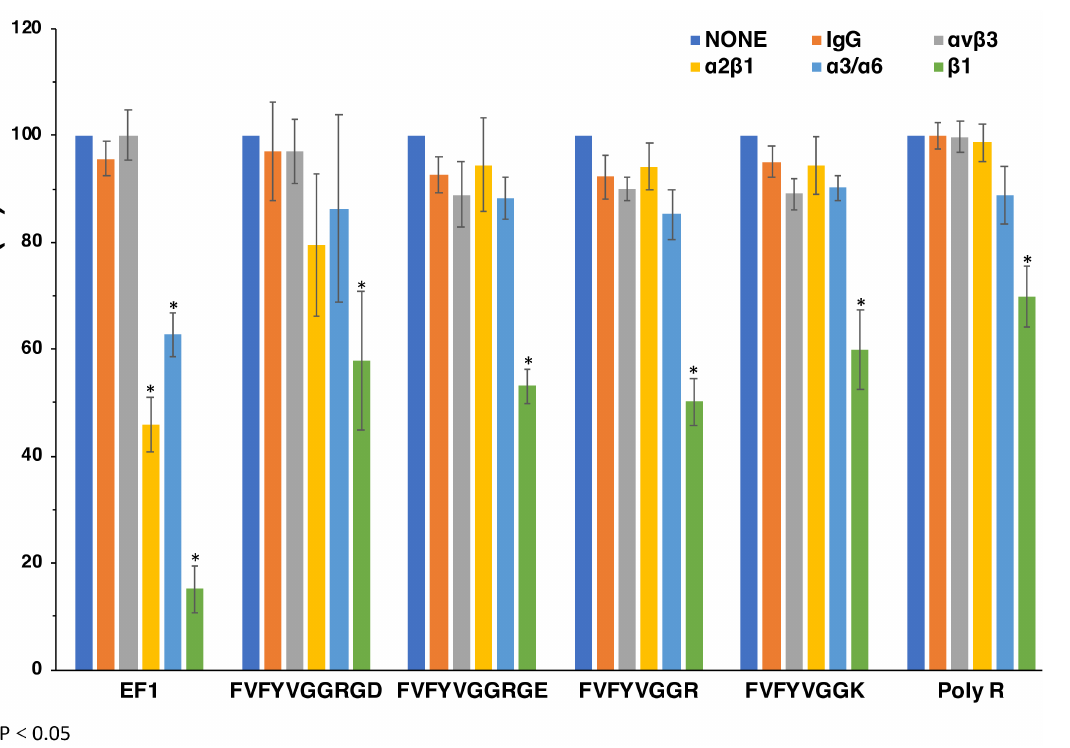
Figure 7. Effect of anti-integrin antibodies on cell attachment to peptides. HDFs were preincubated with 10 µ g/mL of the integrin antibodies at room temperature for 15 min and added to the peptide- coated plates (2 nmol/well of EF1, 5 nmol/well of FVFYVGGRGD and FVFYVGGRGE, 10 nmol/well of FVFYVGGR and FVFYVGGK, 1 ng/well of poly R). After a 1 h incubation, cells were stained with crystal violet and the number of the attached cells was counted. Each value represents the mean of three separate determinations ± S.D. Triplicate experiments gave similar results. * p <